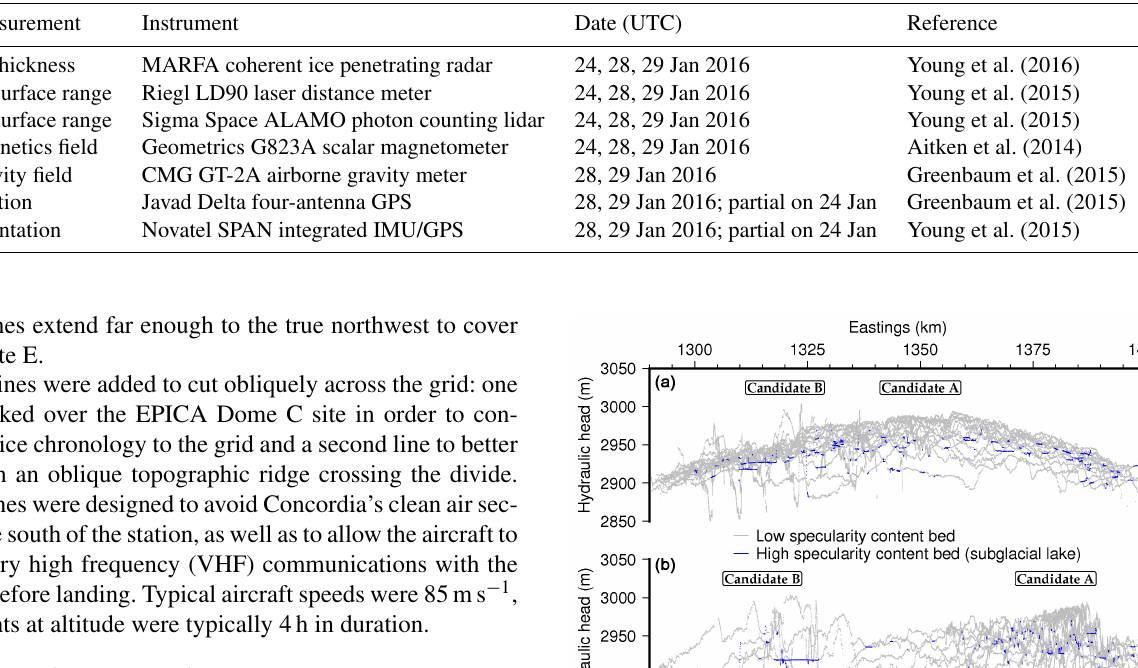
Table 1. ICECAP (OIA) instrument suite.